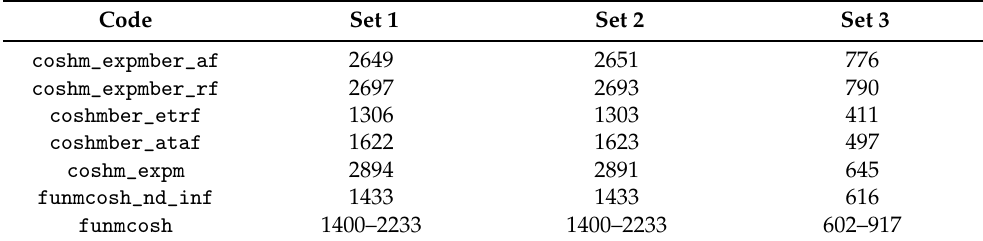
Table 5. Experiment 2: Number of matrix products for all the matrices in a set for each code. Code Set 1 Set 2 Set